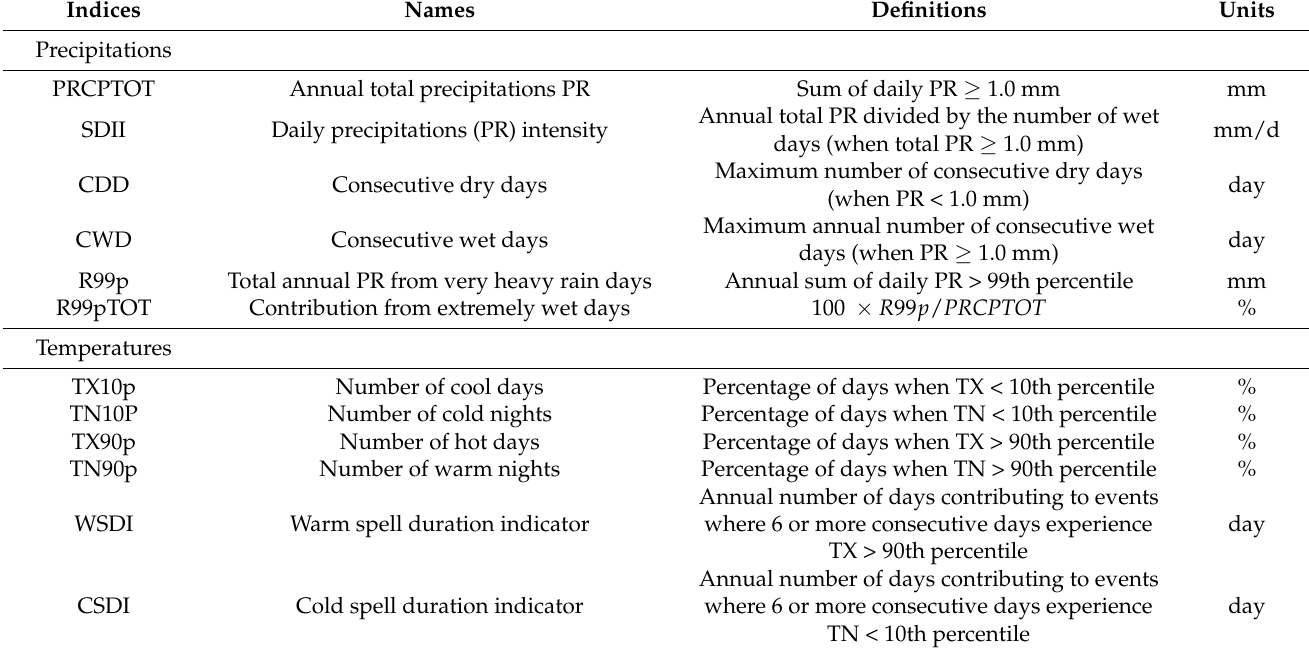
Table 3. Indices of daily precipitation and temperature extremes and their descriptions as defined by